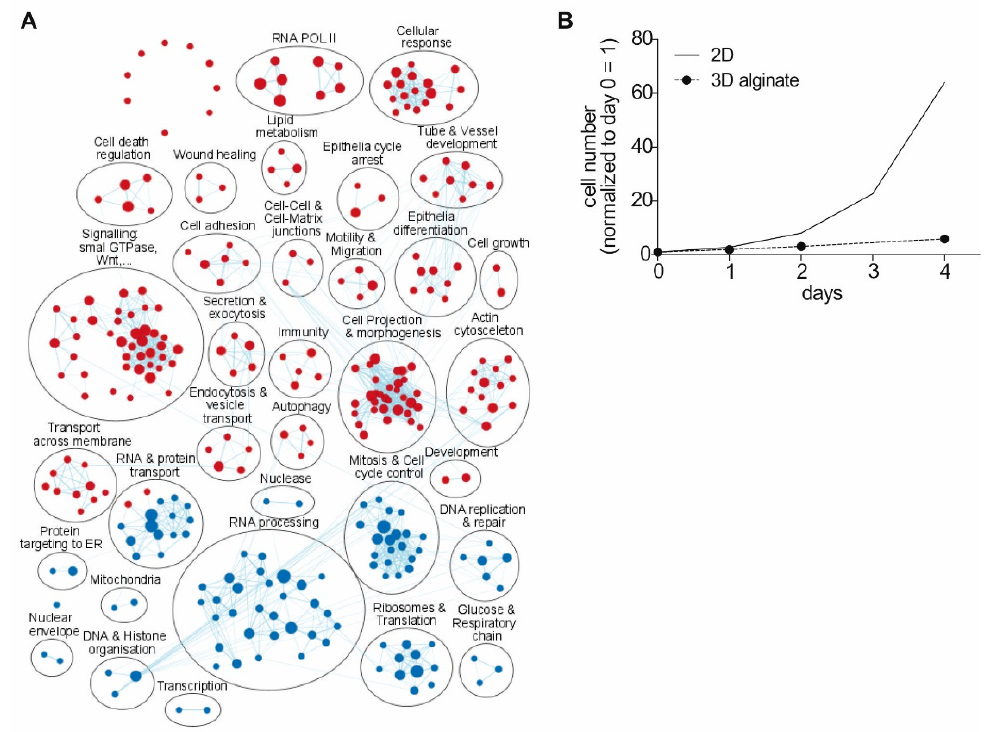
Figure 3. Different phenotypes in 2D and 3D alginate cultured Mel Im revealed by enrichment map analysis. ( A ) Enrichment map from GSEA of GO biological processes gene sets shows a proliferative phenotype (blue) and a principal change in cellular phenotype (red) of 2D and 3D cultured Mel Im cells, respectively. ( B ) Cell numbers of melanoma cell line Mel Im cultivated in 3D alginate over 4 days in culture ( n = 3) were quantified from microscope images and compared to values calculated for Mel Im cultured in 2D with a doubling time of approx. 16 h. Comparison of the growth rates reveals a slower proliferation rate in 3D alginate (plotted as mean ± SD).